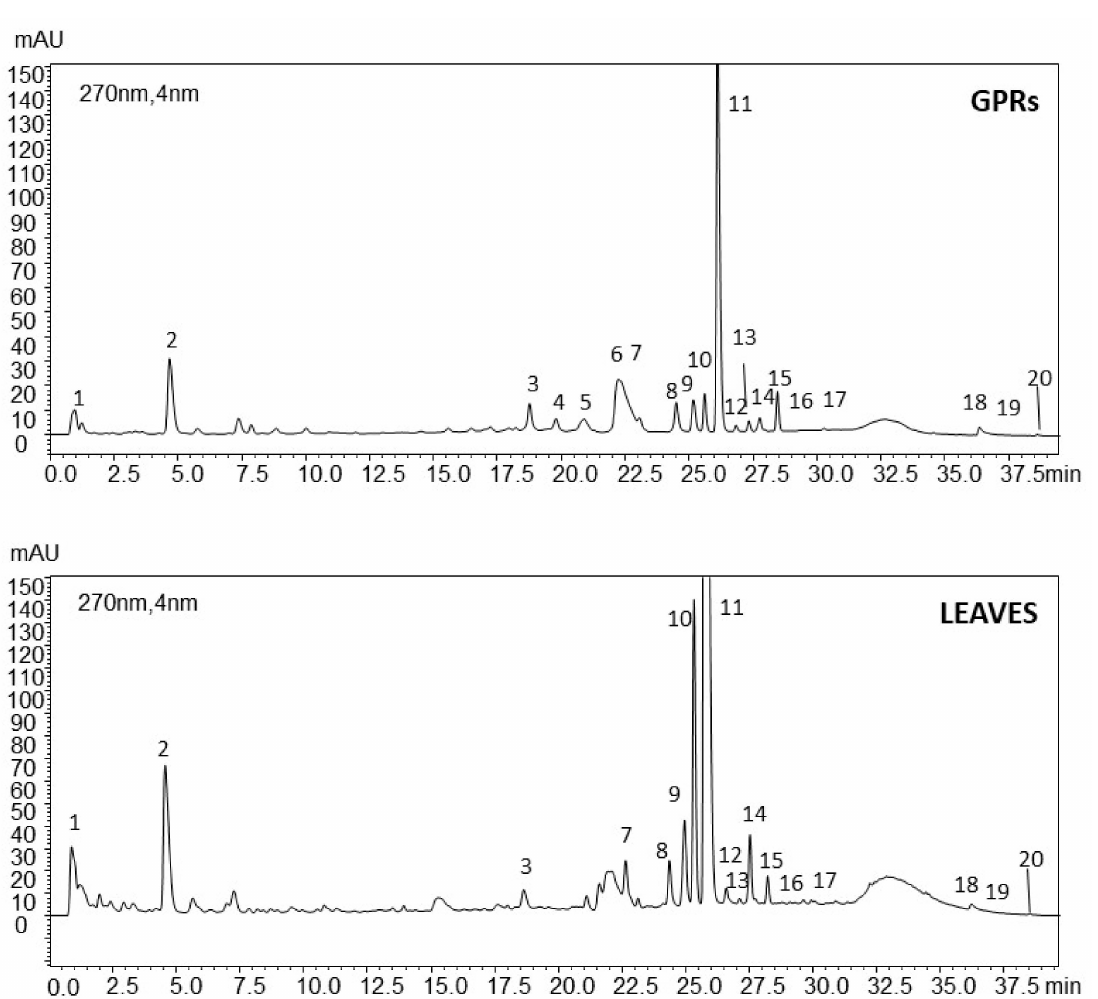
Figure 1. HPLC-PDA profiles ( λ , 270 nm) of green pruning residues (GPRs) and leaves. For peak numbers see Table